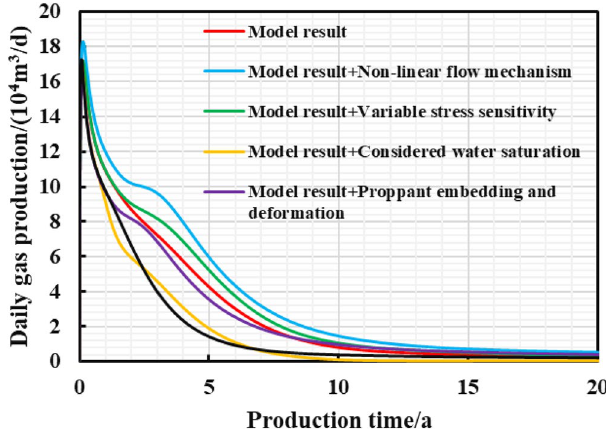
Figure 15. Diagram of the cumulative gas production and time for different models.